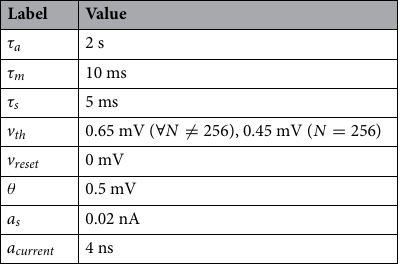
Table 1. Parameters of the AdEx neuron model used in the current